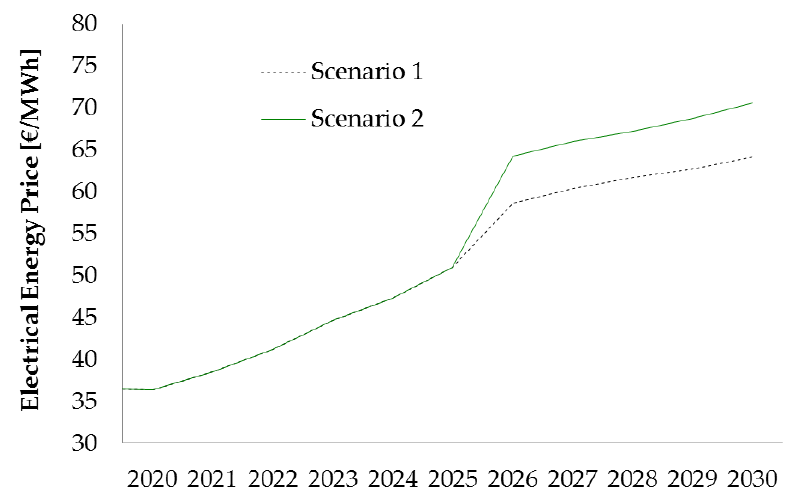
Figure 10. Yearly average PUN trend with HYP.2 (considering bid-ups).